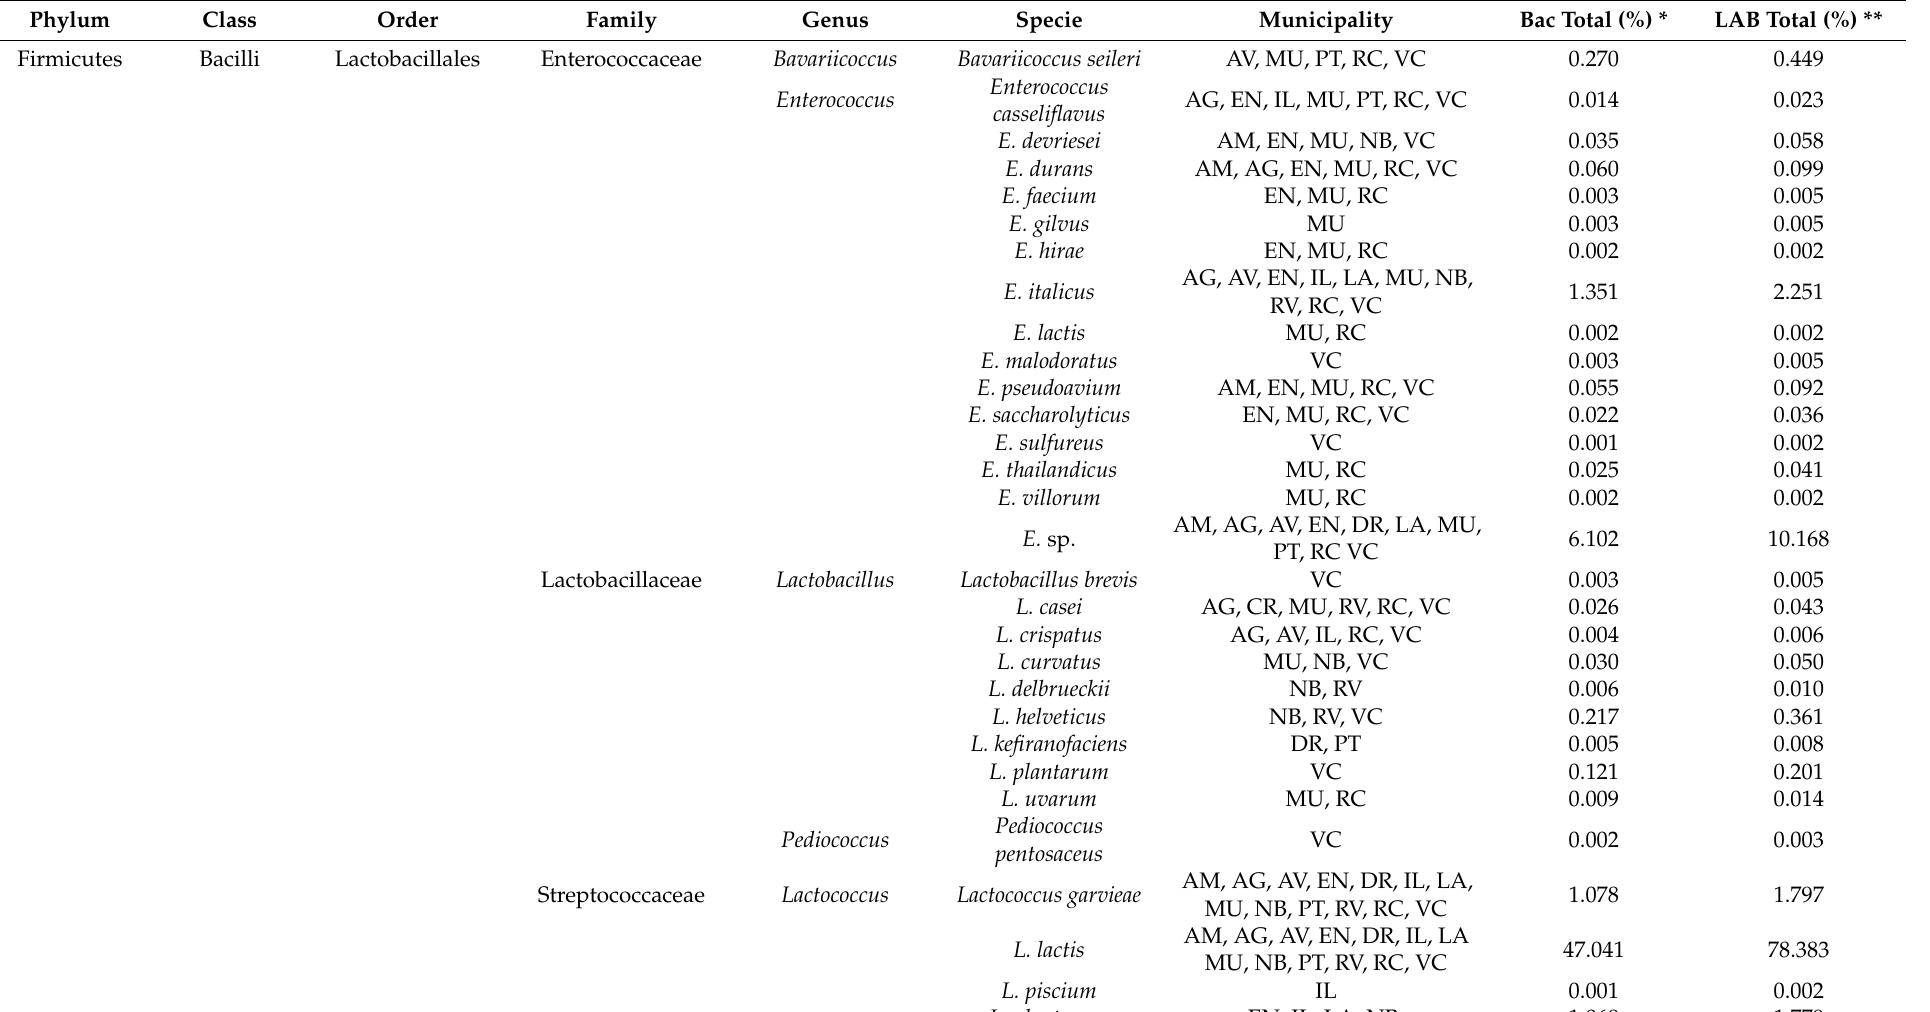
Table 1. Diversity and abundance of bacterial species present in artisanal cheese samples (n =